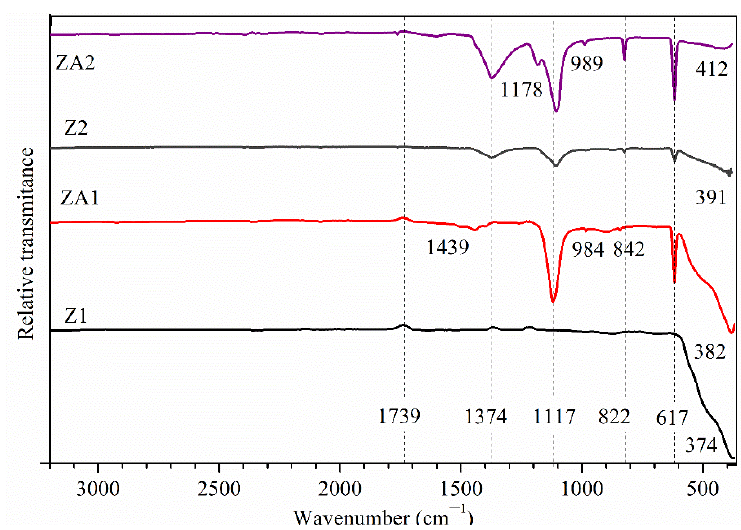
Figure 4. ATR-FTIR spectra for ZnO (Z1 and Z2) and ZnO/Au (ZA1 and ZA2) samples.